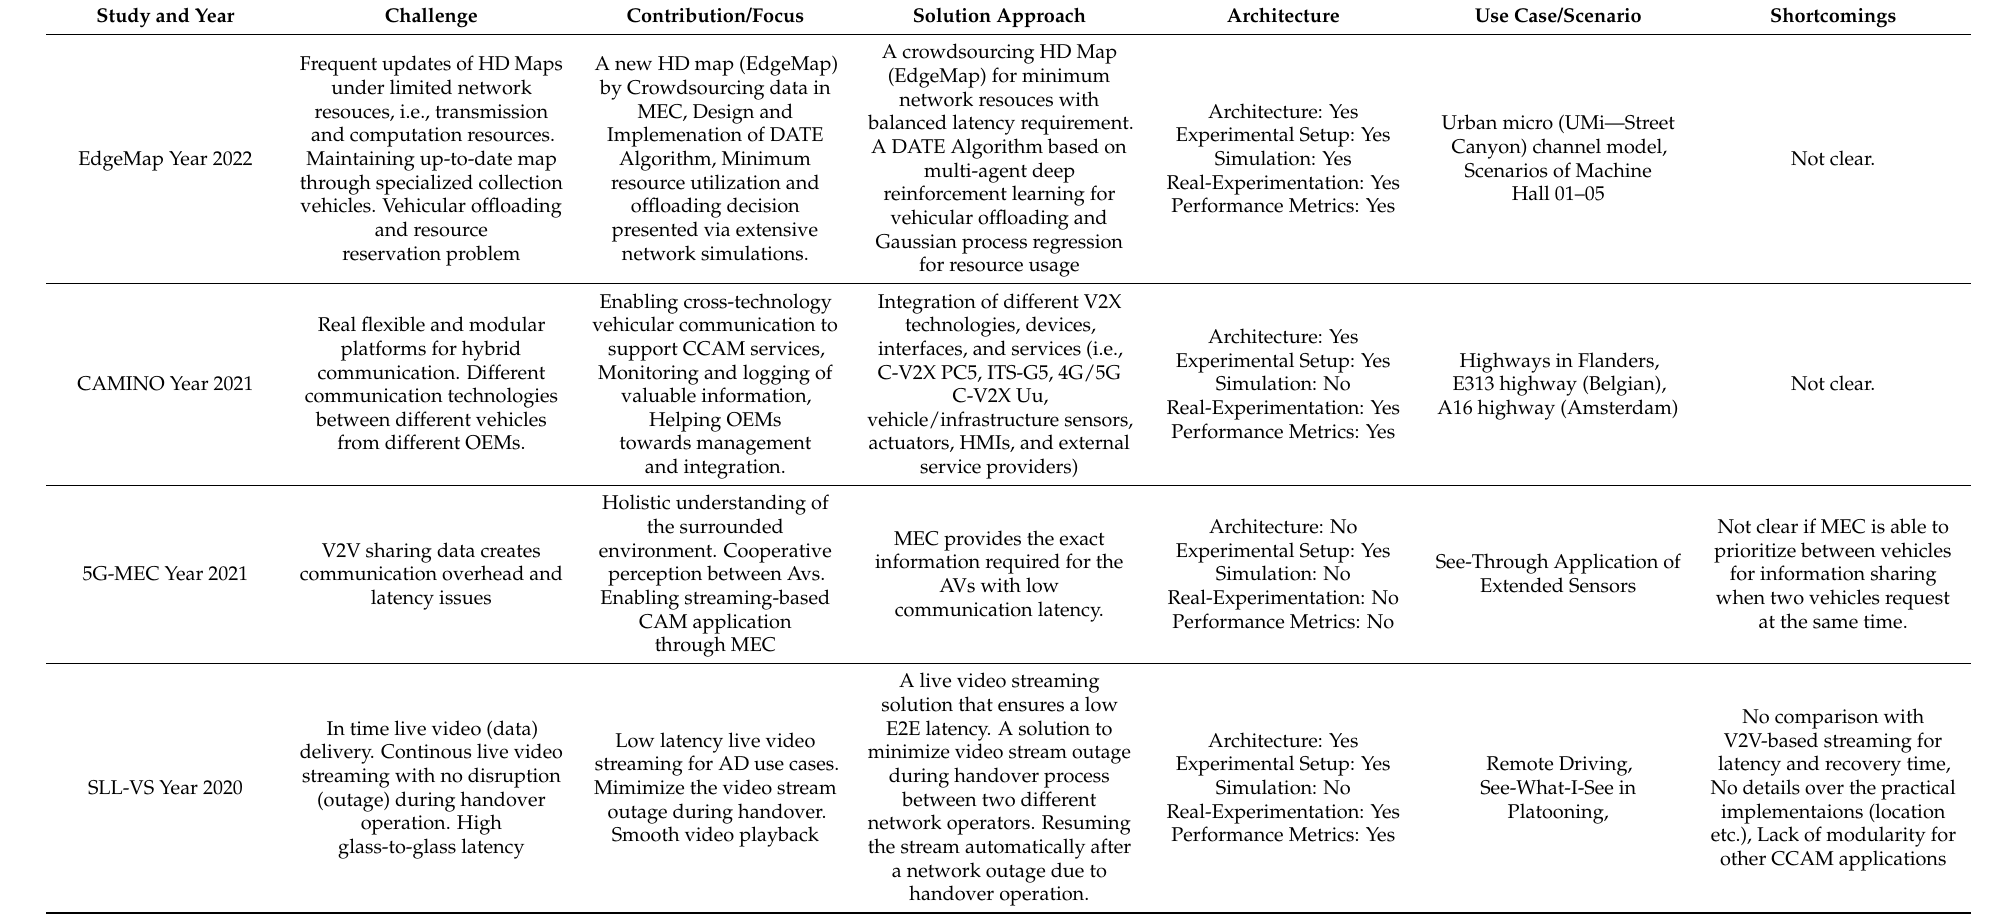
Table 1. Achieving perception through information available in roadside